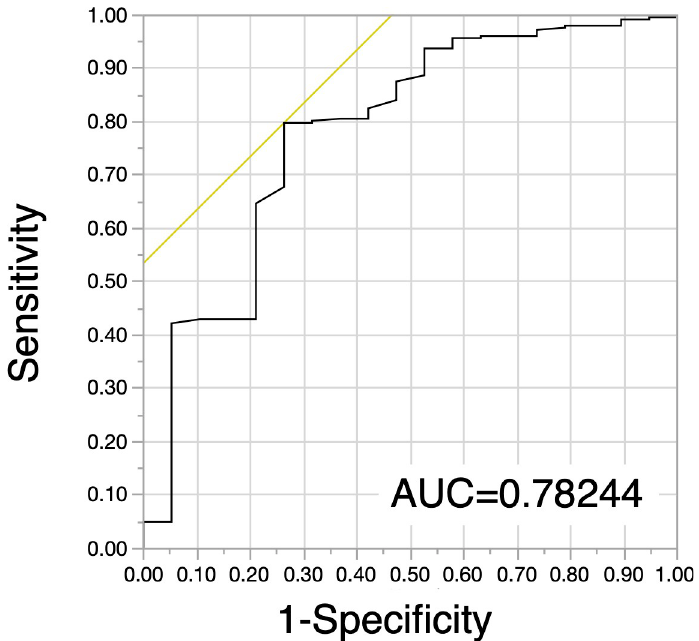
Fig 2. Receiver operating characteristic curve (ROC) of training cohort (TC). ROC curves for postoperative decrease in serum albumin ( Δ Alb) in the TC. AUC: Area under the curve.